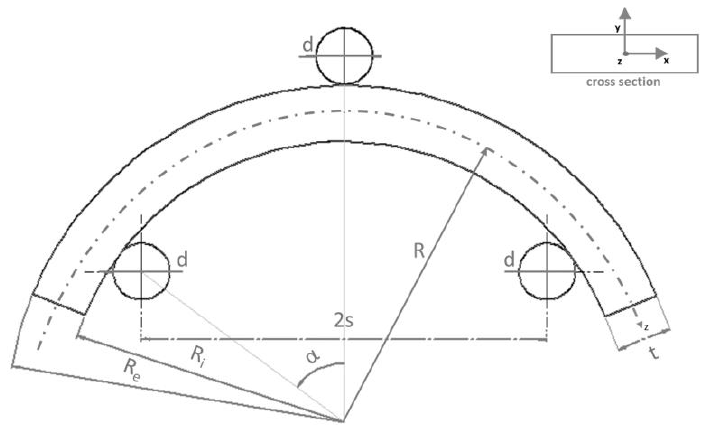
Figure 2. Representation of the experimental set-up for the three-point bending test. The specimen is represented by the arch, which lays on the support rollers. On the top of the specimen is the loading roller that transmits the force applied by the testing machine.